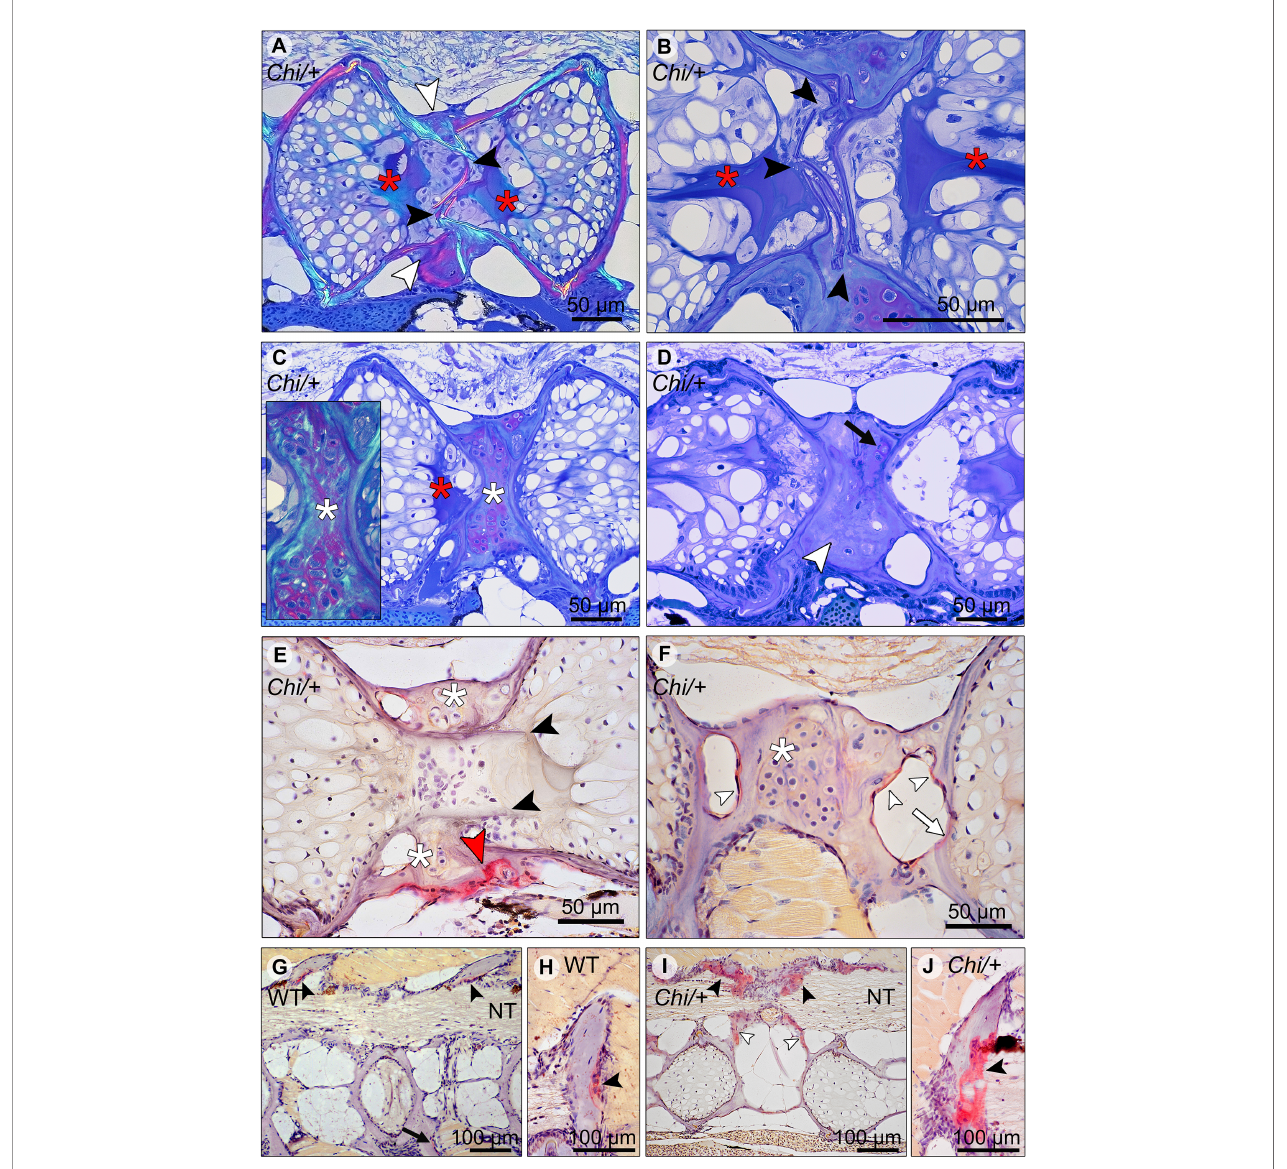
FIGURE 6 | Compression fractures and bone resorption in Chi/+ and Chi /+ LP vertebral bodies. (A) Toluidine blue stained medio-sagittal section of a compression fracture from three months old mutant zebra fi sh (representative for both Chi /+ and Chi /+LP) observed with polarised light. The compression fracture is characterised by several fractures in the central region of the vertebral body (black arrowheads); a bone callus is present on the outside of the vertebral centrum (white arrowheads). The fracture also disrupts the notochord tissue and induces condensation of chordocytes into a fi brous tissue (a known reaction of notochord tissue to injuries) (red asterisks). (B) High magni fi cation of the fractured bone (black arrowheads) inside the notochord. The reaction of the notochord tissue can be seen (red asterisks). (C) A fi brocartilaginous callus is present around the fractured central part of the vertebral body, the typical appearance for fracture callus at initial stages of repair (white asterisks). Polarised light (insert) shows collagen fi bres (green) within the cartilaginous callus. Red asterisk indicates the notochord tissue condensation. (D) Sagittal section of a healed compression fracture. Fracture repair and remodelling processes replaced the fi brocartilaginous tissue by a bone callus (white arrowhead). Remnants of the fi brocartilaginous tissue are visible (black arrow). (E) Tartrate-resistant acid phosphatase (TRAP) staining con fi rms compression fracture repair. TRAP activity (red staining, red arrowhead) indicates resorption of the fi brous tissue (white asterisks) that is being replaced by a hard bone callus. The fractured bone fragments (black arrowheads) in the lumen of the notochord do not show resorption, which is consistent with the absence of blood vessels, lymphatic vessels and innervation inside the notochord. (F) TRAP activity is detected also in the trabecular bone (white arrowheads) and vertebral endplate (white arrow) of a vertebra showing a compression fracture in mutant zebra fi sh (representative for both Chi /+ and Chi /+ LP ). White asterisk indicates the fi brocartilaginous callus. (G, H) WT display TRAP activity (red) at sites of bone remodelling linked to bone growth, i.e. the endosteal surfaces of the neural (black arrowheads) and haemal arches (black arrow). NT, neural tube. (I, J) Chi/+ animals (representative also for Chi /+ LP ) show TRAP activity at the same locations as in WT, however mutants exhibit expanded TRAP activity at all endosteal and periosteal bone surfaces, i.e. arches (black arrowheads) and bone trabeculae connecting the endplates (white arrowheads). NT, neural